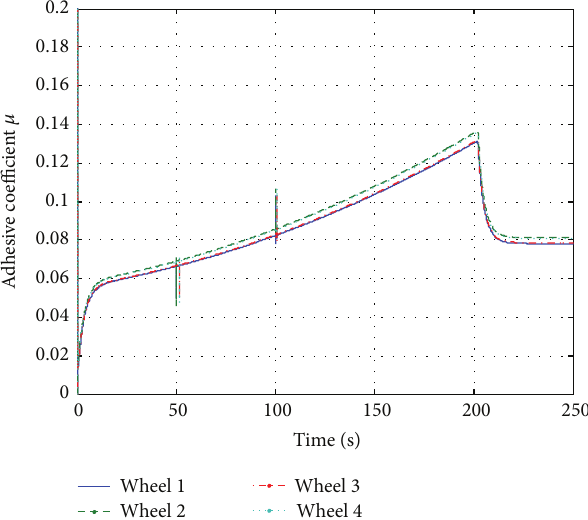
Figure 8: Rotational speed of each driving wheel.